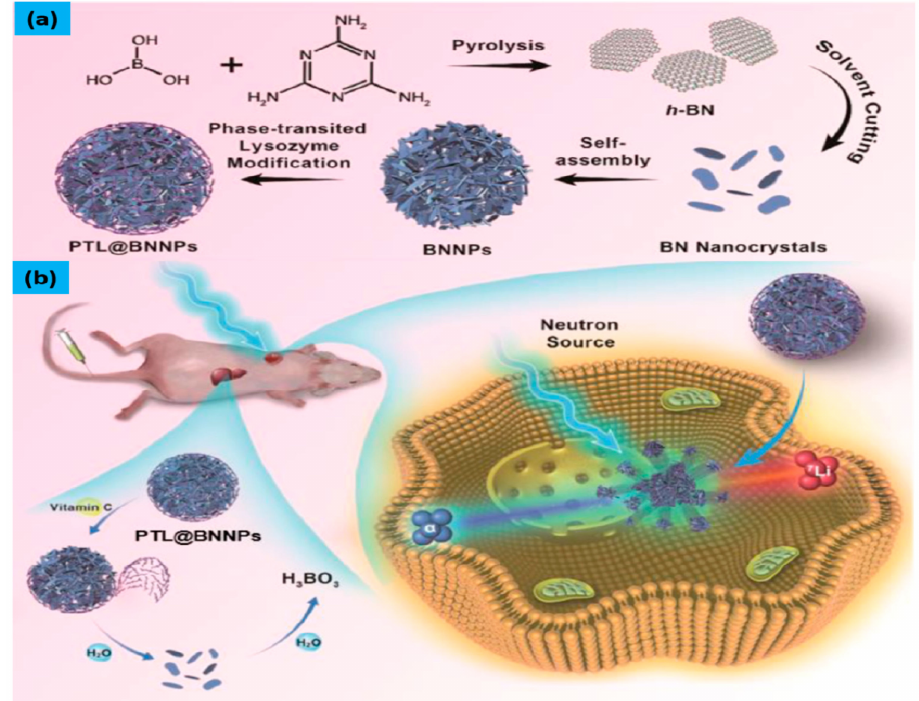
Figure 6. ( a ) Schematic representation of the synthesis of the PTL@BNNPs, ( b ) Illustration of PTL@BNNPs Based BNCT and its degradation (Reprinted from Ref.